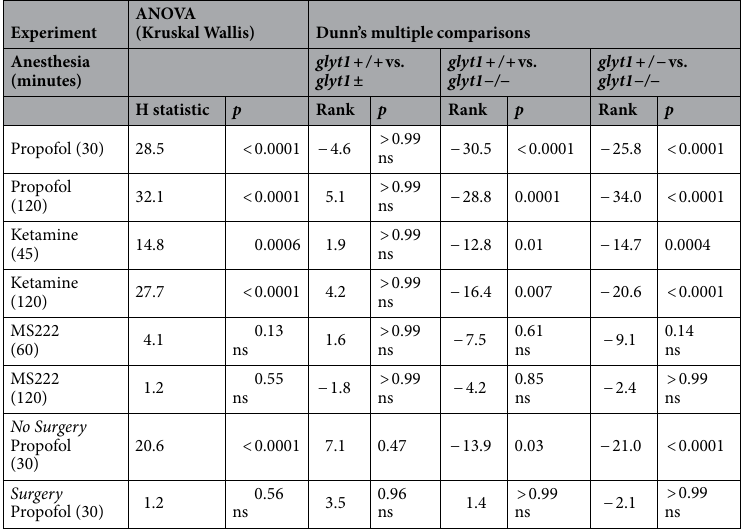
Table 1. glyt1−/− mutant larvae take longer to emerge from propofol and ketamine but not tricaine. Times to emergence from different anesthetics are compared across glyt1 genotypes. Shown are Kruskal Wallis ANOVA H-statistic and p -value followed by Dunn’s multiple comparisons rank and p